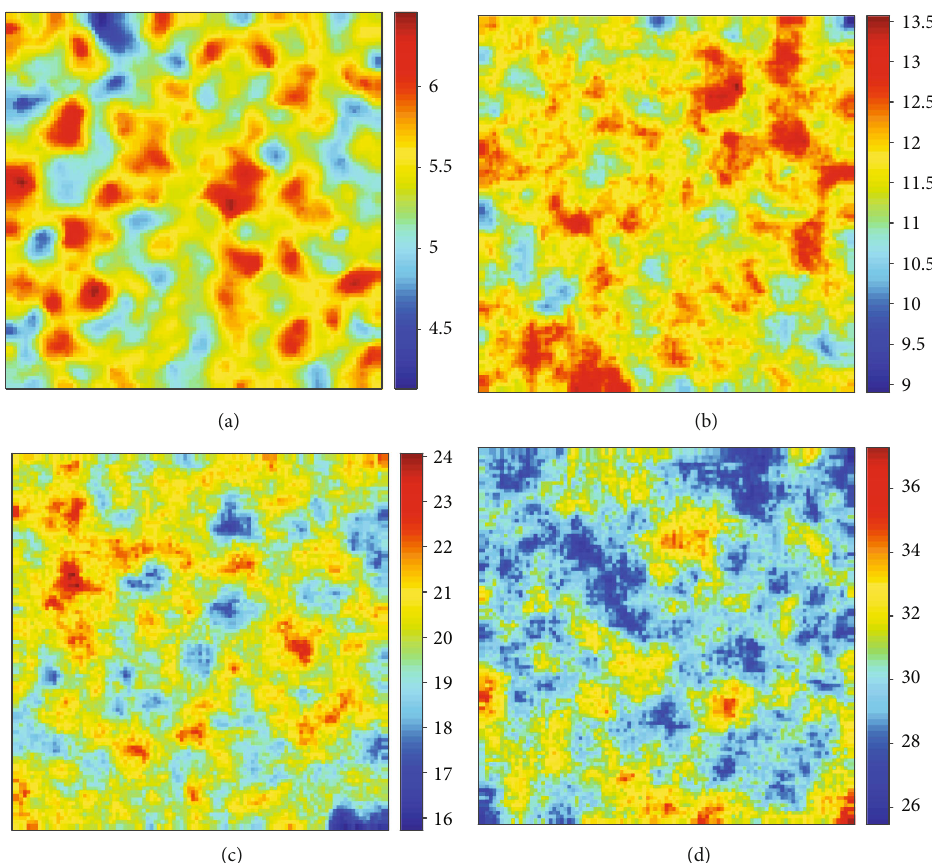
= 0 : 4 ), b ( o = 0 : 6 ), k k